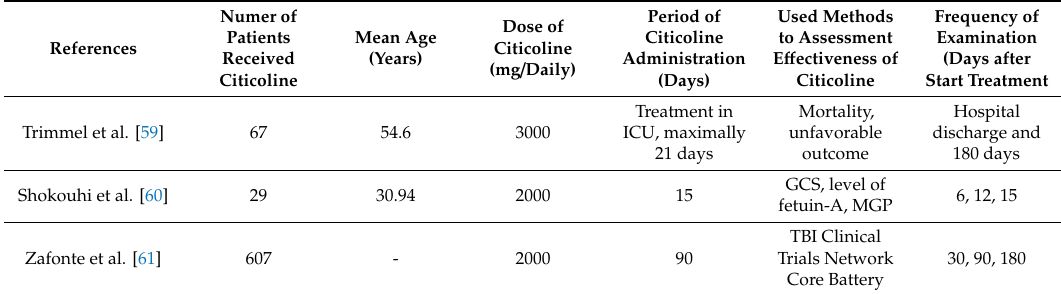
Table 4. Key clinical features of studies in patients after traumatic brain injury